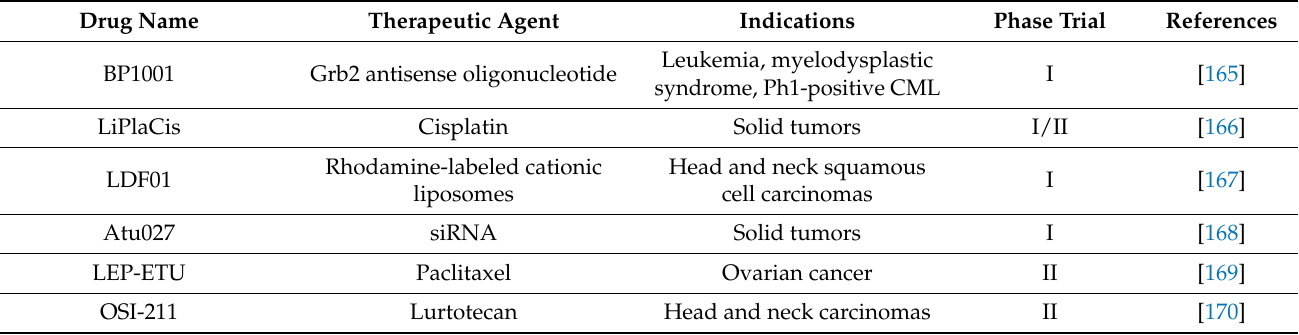
Table 4. Liposomal formulations of various anti-cancer agents under clinical